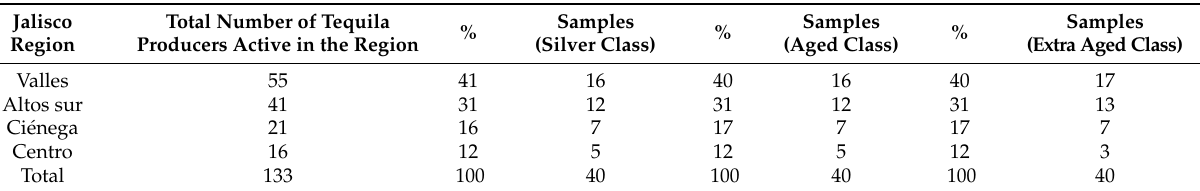
Table 3. Determination of the number of samples for tequila 100% agave (silver, aged, and extra-aged class) based on a stratified sampling method by proportional allocation taking into consideration the distribution of tequila producers located in Jalisco, Mexico.